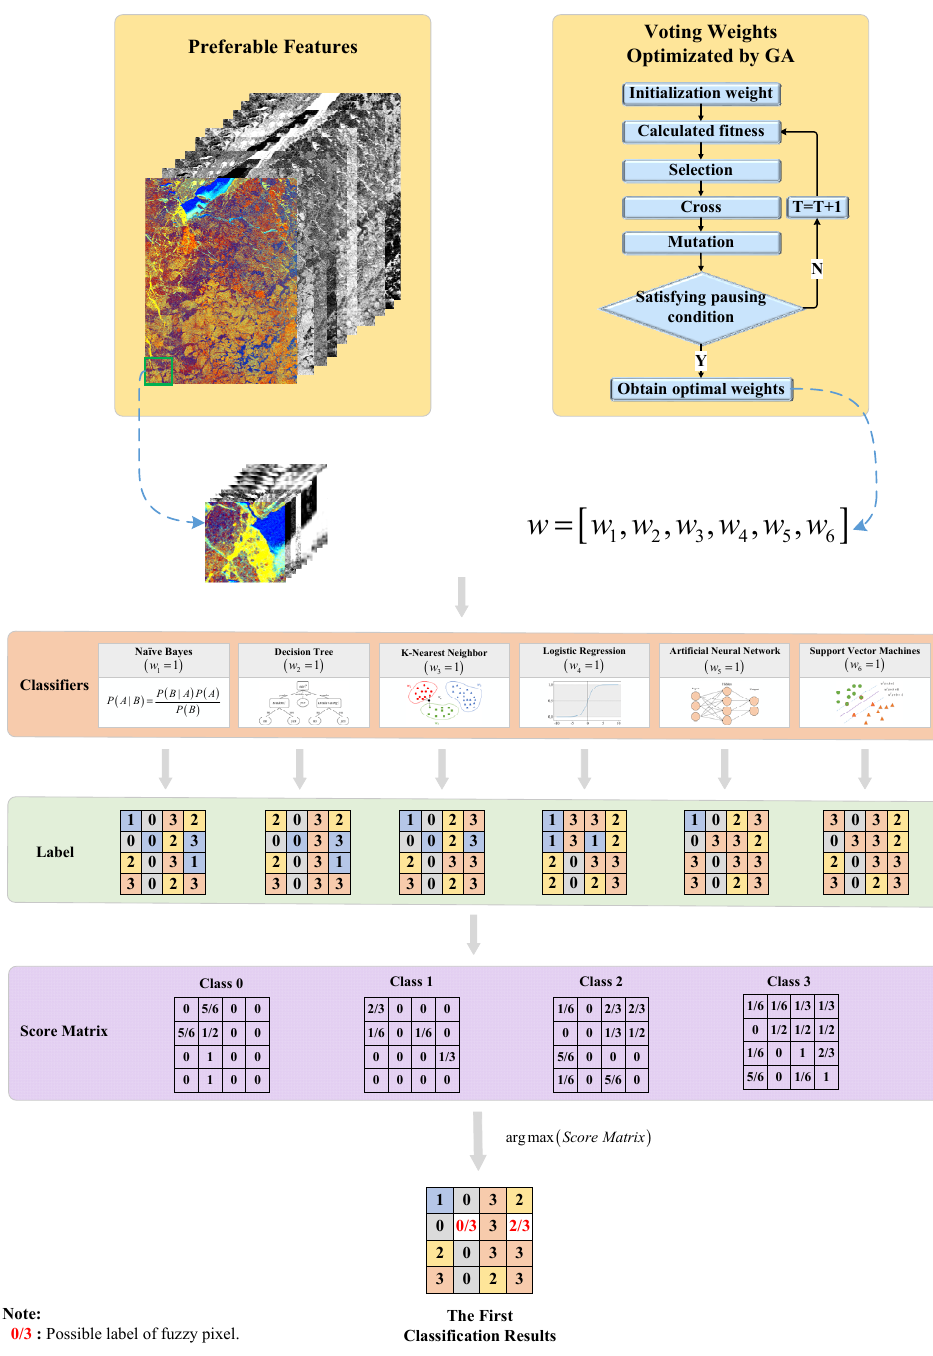
Figure 4. The first coarse classification results after the 1st round voting stage.